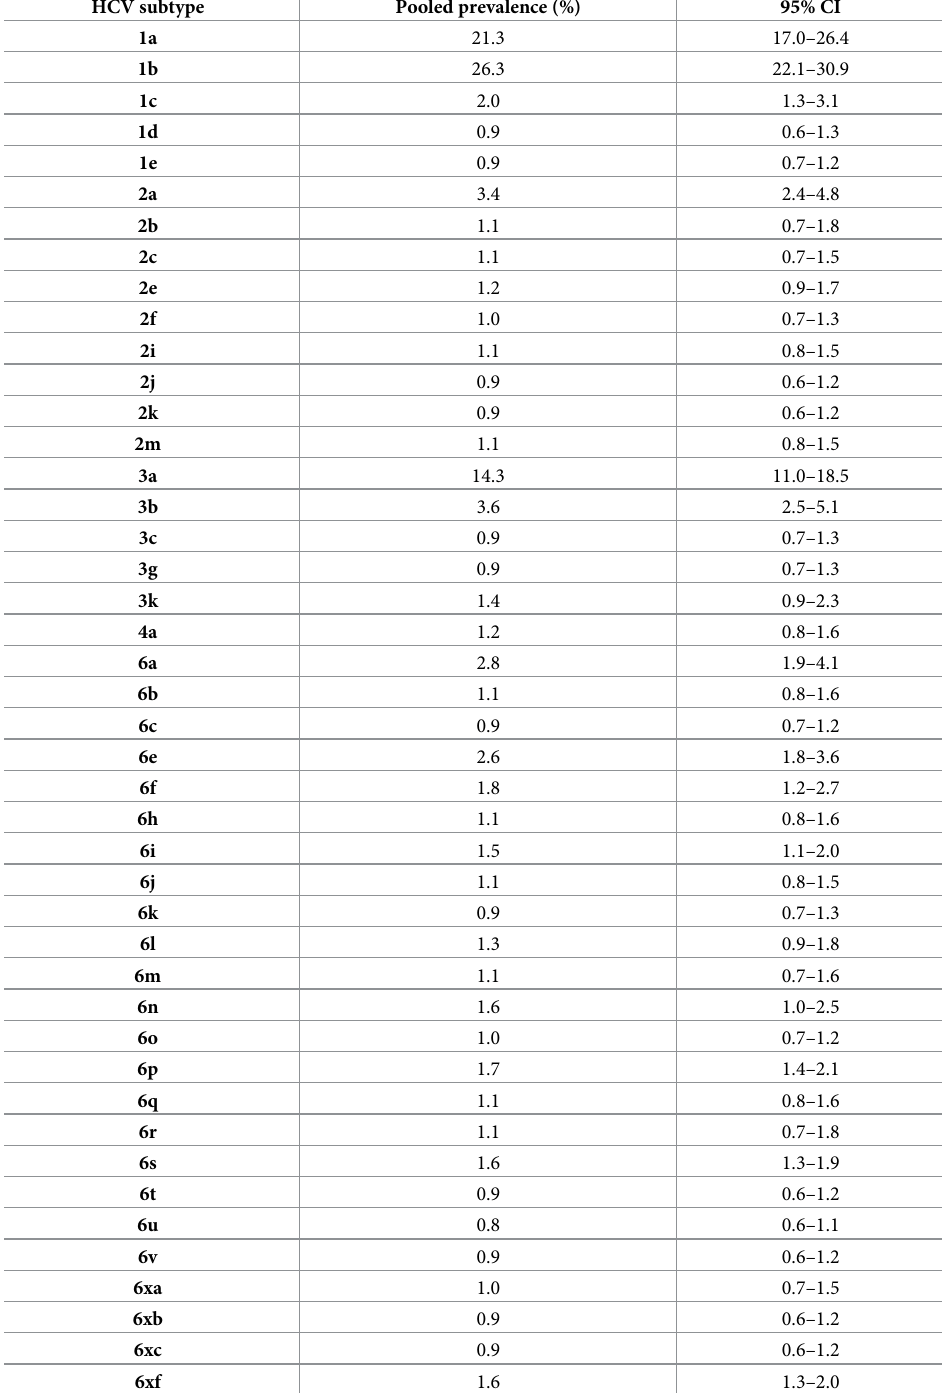
Table 4. Prevalence of HCV subtypes in Southeast